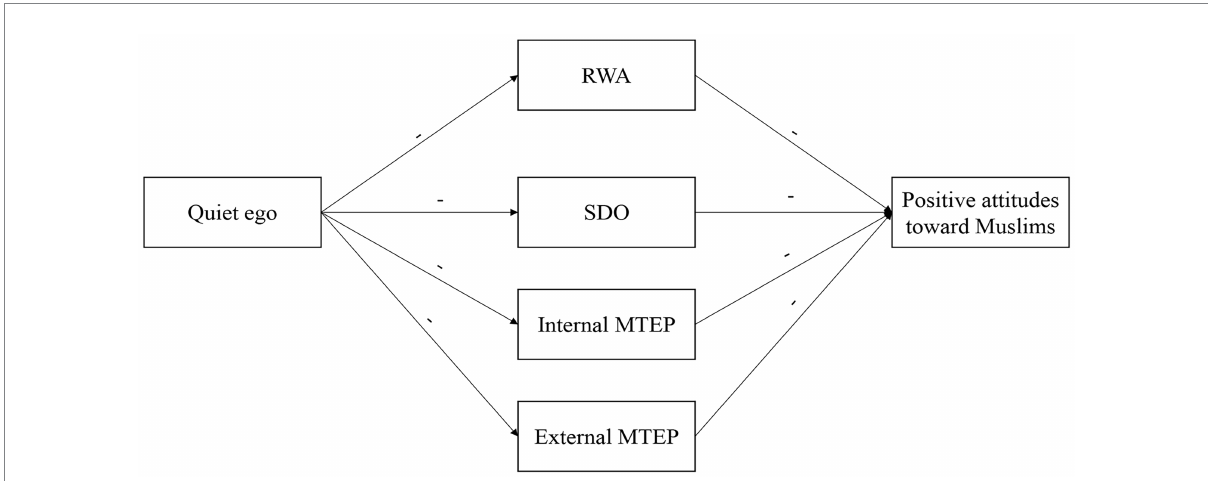
FIGURE 1 Hypothesized mediation model depicting expected paths between variables. Paths denoted by a “-“ denotes an expected negative